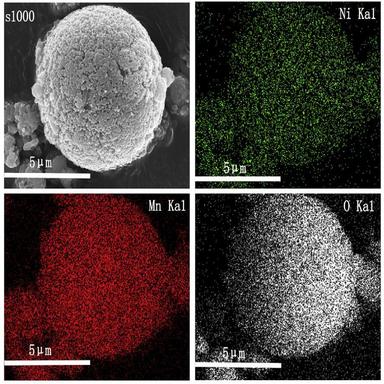
The elemental mapping images of s1000 sample.